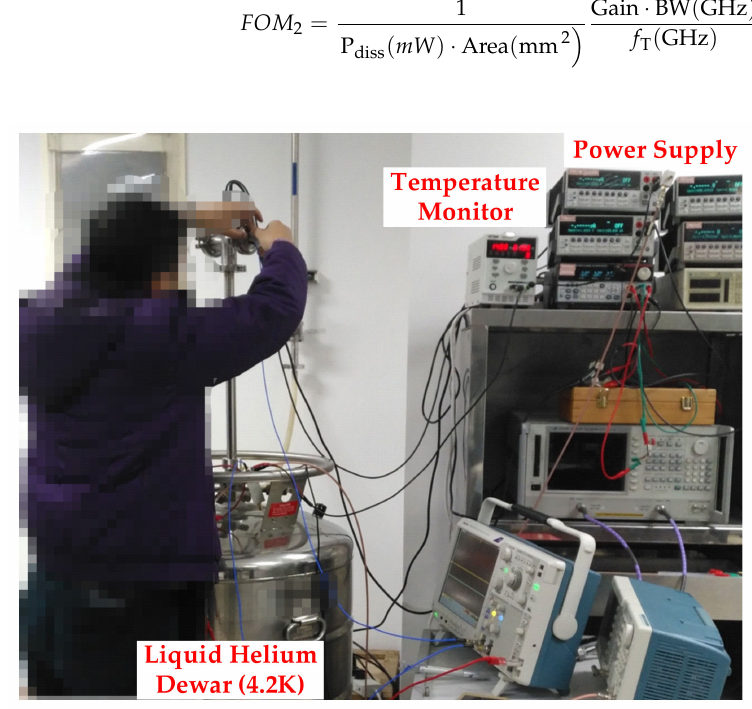
Figure 13. The measurement setup at cryogenic temperature.